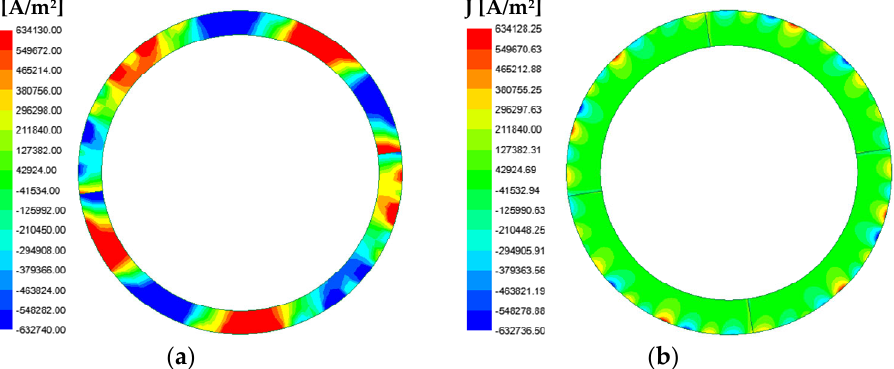
Figure 7. The rotor magnet eddy-current density distribution of two-pole and four-pole motors under rated load: ( a ) two-pole motor; ( b ) four-pole motor.